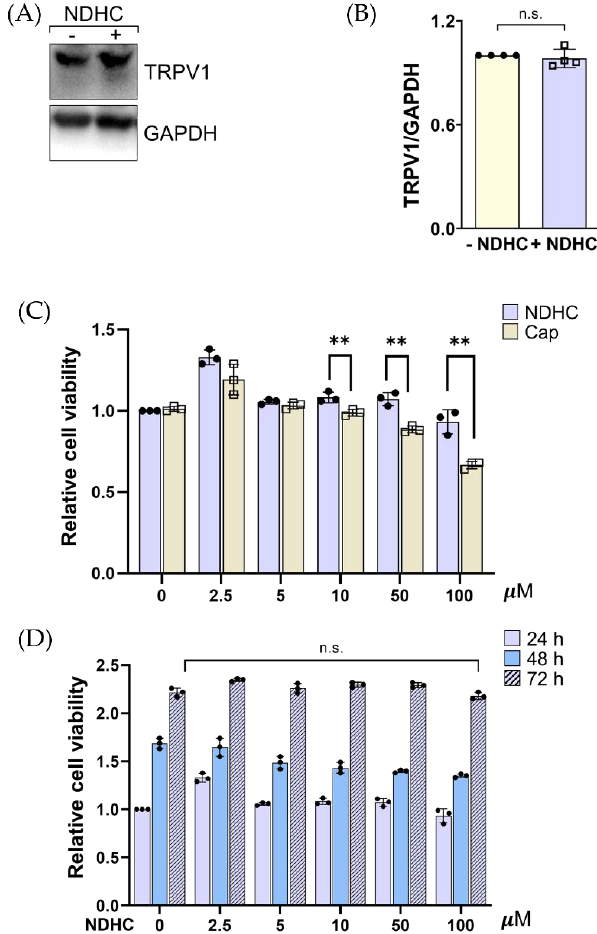
Figure 2. ( A ) Western blot analysis shows the expression of TRPV1 on HLE cells. After treatment with 10 μM NDHC, cell lysates were separated by SDS-PAGE and the Western blot was probed with anti-TRPV1 antibody. ( B ) Relative TRPV1 expression. Quantification of signal intensity, pre- sented as the ratio of TRPV1 to corresponding GAPDH relative to the TRPV1 expression in un- treated cells. ( C ) The viability of HLE cells treated either with NDHC or Cap at different concentra- tions for 24 h was examined by Alamar blue fluorescence (Ex 530, Em. 590 nm). ( D ) The viability of HLE cells treated with different concentrations of NDHC in a time-dependent manner was assessed by Alamar blue assay. Data are representative of 3 independent experiments (mean ± SD). ** p < 0.01, n.s. = not significant. n.s. = not